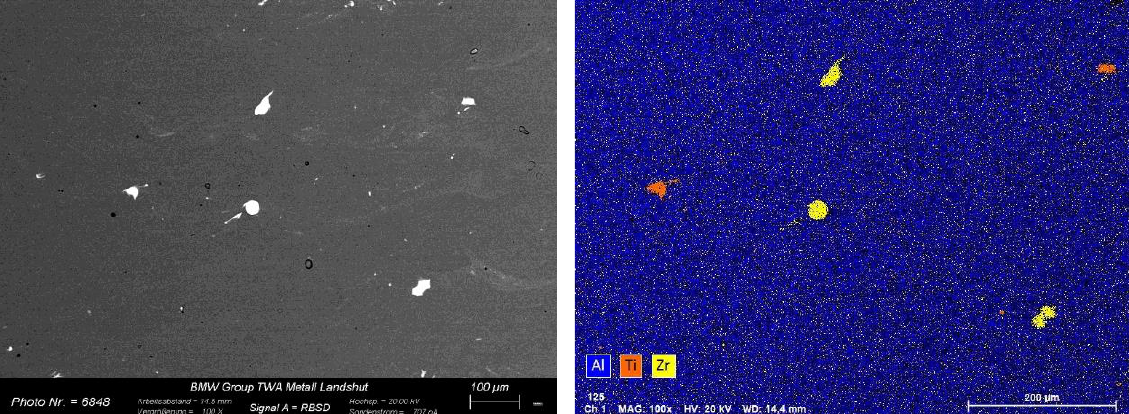
Figure 5. SEM micrographs ( left : BSE mode, right : EDX mapping) of the as-built LPBF specimen manufactured with the powder mixture.